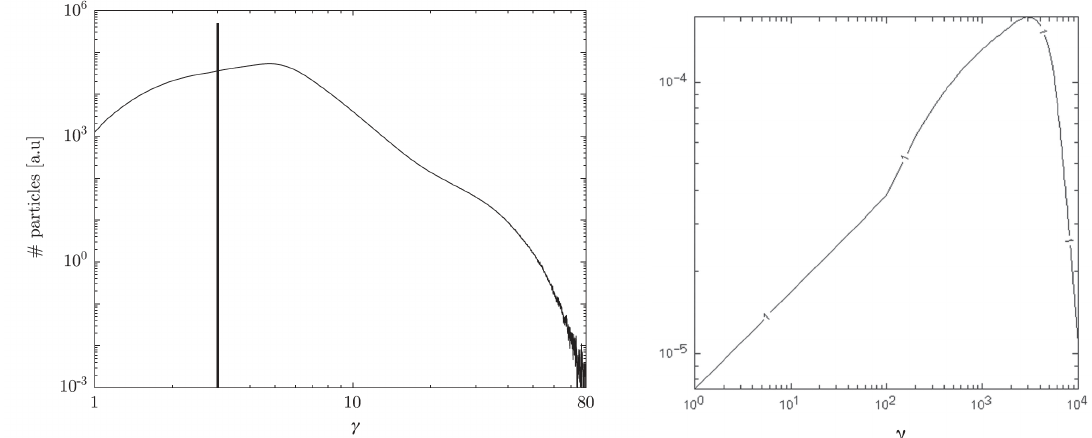
Figure 3. Left: Resultant electron energy distribution for a relativistic, cold electron-proton shear flow with γ 0 = 3 at time t = 10 3 / ω pe . At low energies (1 < γ e < 5) the distributions resembles a thermal one, while in the intermediate range γ e = 5 − 25 it exhibits some smooth (power-law-type ∼ γ − 5 e ) evolution. After some hardening, a tail is seen extending up to γ e Right: Electron energy distribution in the case of a relativistic shear flow with γ 0 = 5 at late times t = 10 4 / ω pe . The distribution peaks around γ e ∼ 3000, but shows little evidence for a conventional power-law behaviour. Both distributions refer to the center-of-momentum frame. From Ref.